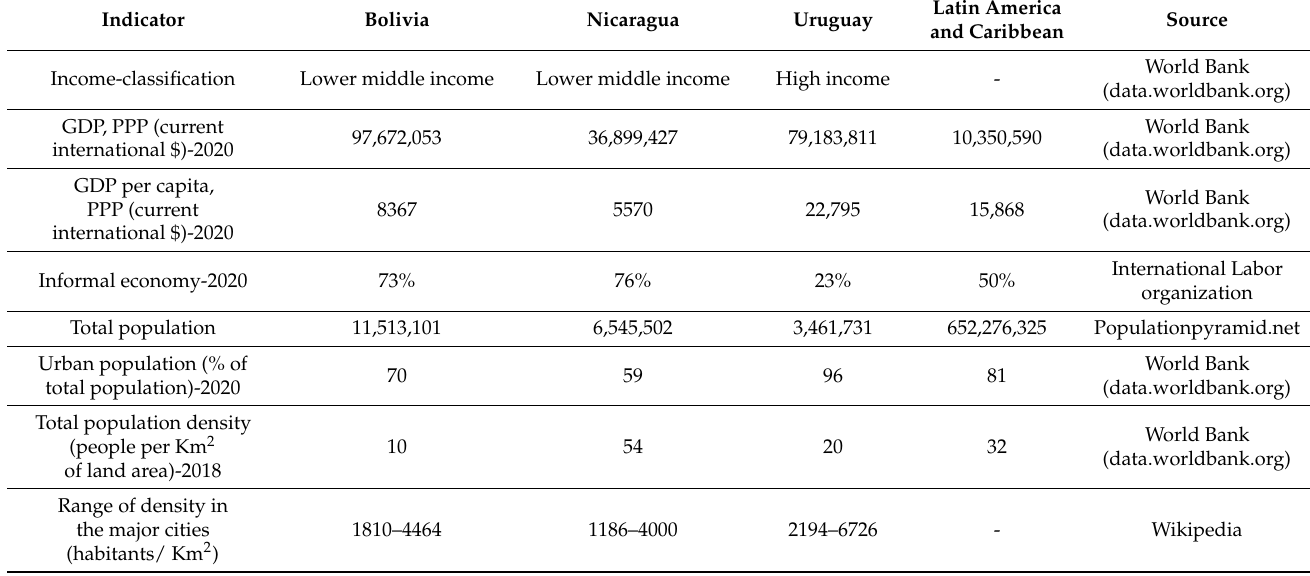
Table A1. Country